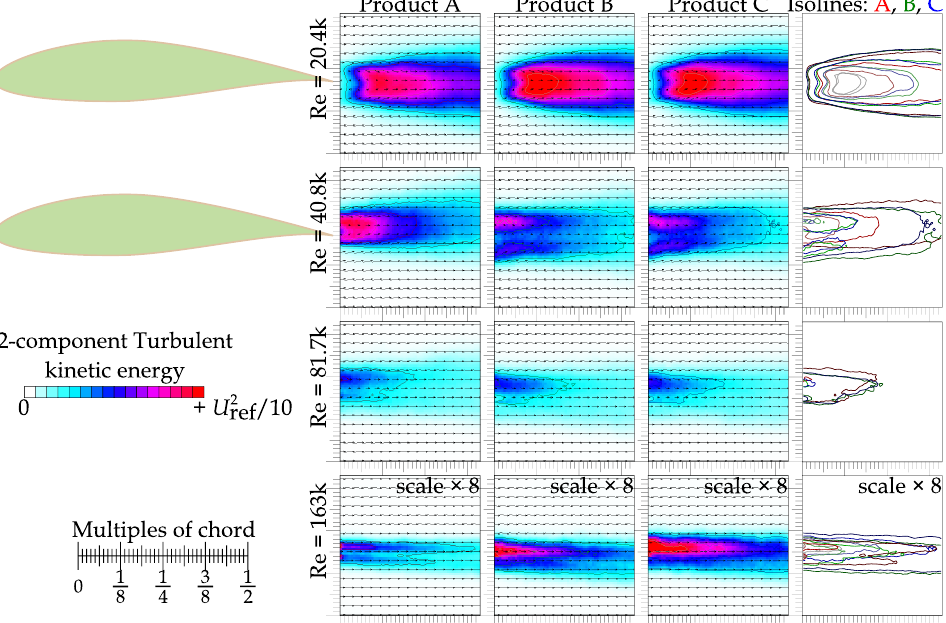
Figure 13. Turbulent kinetic energy (TKE) based on in-plane velocities only (thus, it is thought to be underestimated) obtained behind three different manufactured samples denoted A, B, and C. The U 2 scale is adapted to 1 except for the last line, where the scale is 1 10 ref all